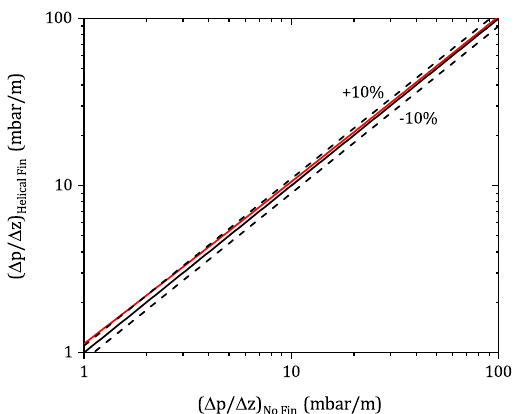
Figure 7. Parity plot, comparing the specific pressure drop of the reactor without fins, and the one with helical fins. The provided data is based on polynomial fitting of the simulation data according to Equations (23) and